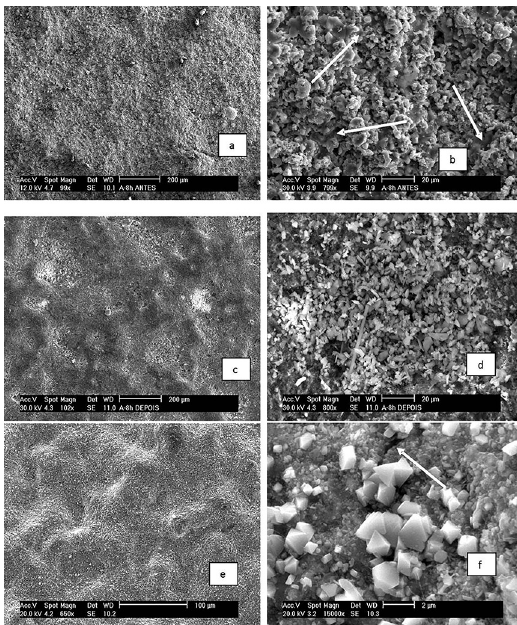
Figure 3. Secondary electron micrographs showing the surface of a sample coated with nanostructured Cr